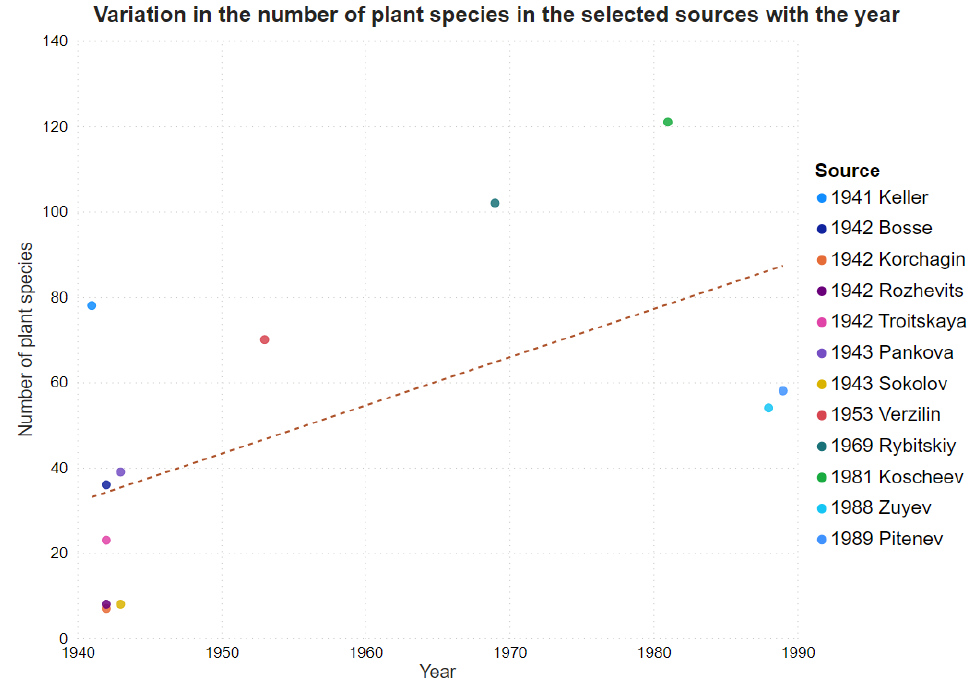
Figure 7. The relationship between year and the number of plant species in the sources. A total of 41 generalized use modes of plants were reported during the post-war period, while only 28 were mentioned during WWII. Additionally, four selected food uses were analyzed to compare the results for the wartime and post-war periods (Table 3).